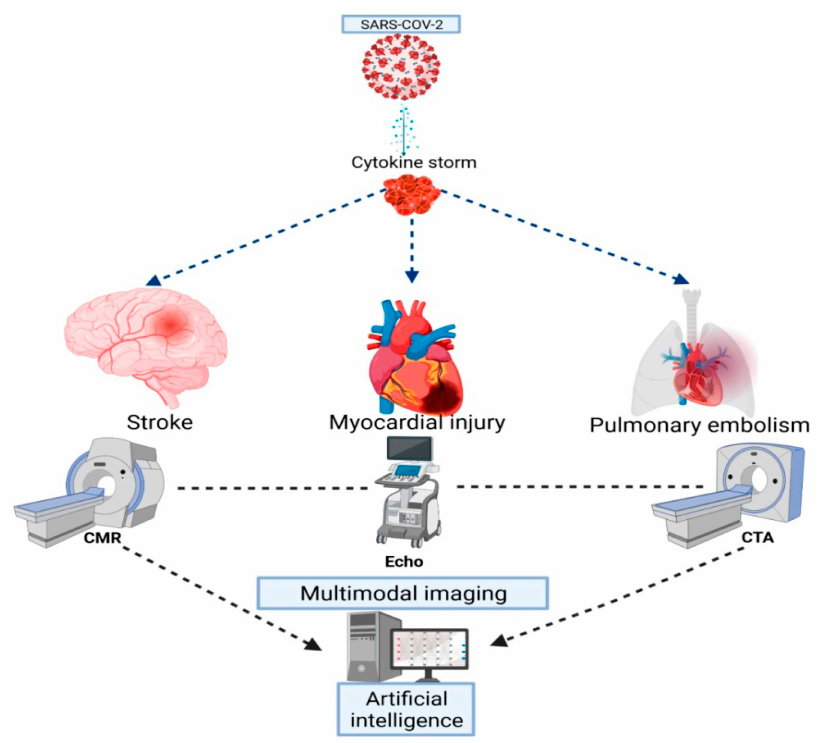
Figure 3. Summarization of cardiovascular imaging techniques in COVID-19 patients.